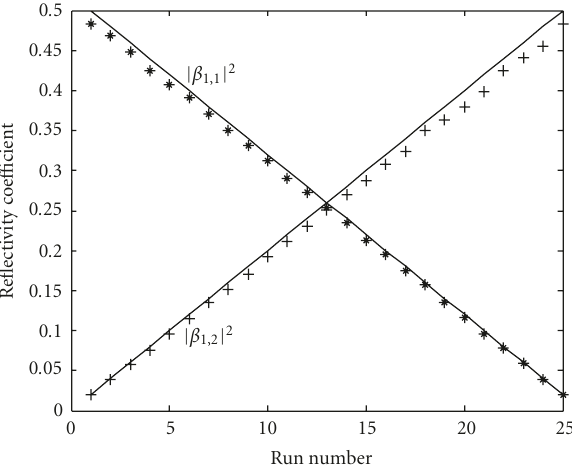
Figure 5: The estimated value of the reflectivity parameters β 1,1 and β 1,2 with | β 1,3 | 2 = | β 1,4 | 2 = 1 / 30. Straight lines represent the simulated values, and ∗ or + represents the